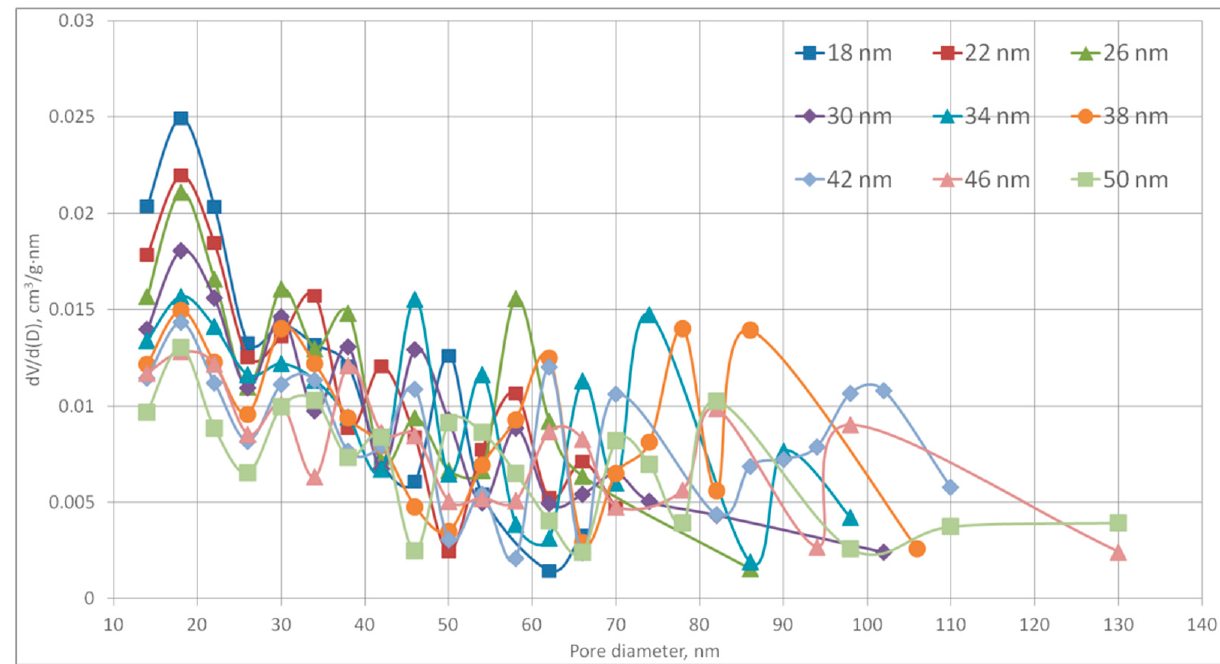
Figure 16. Pore size distribution of digital structures with 65% porosity and different fiber diameter values.